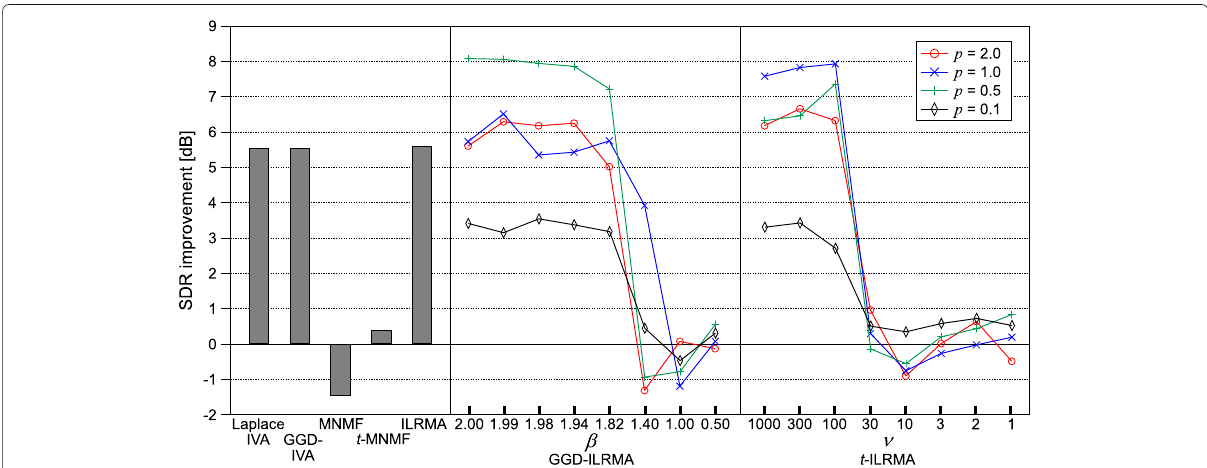
Fig. 9 Average SDR improvements of Speech 2 with E2A_1 signal using fixed parameters. The results for GGD-IVA and t -MNMF using β = 1.0 and ν = 1 are shown, which are their best parameter settings